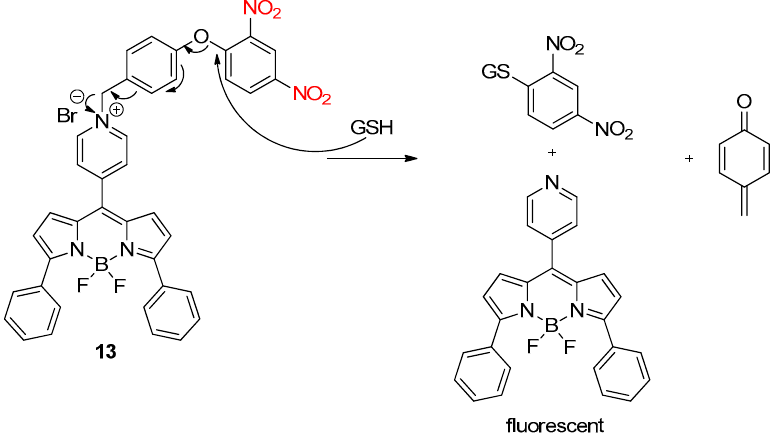
Scheme 17. Plausible mechanism for the selective reaction of probe 13 to GSH .